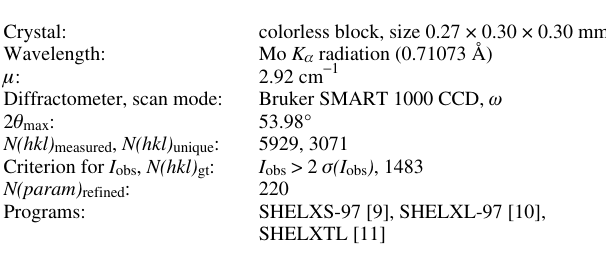
Table 1. Data collection and handling.